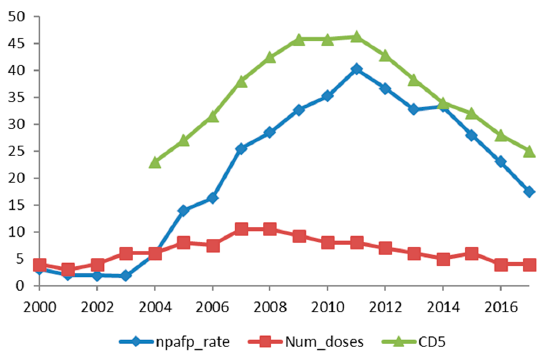
Figure 1. Non-polio AFP over the years in the state of UP alongside the 5-year cumulative doses of OPV. npafp_rate: Non-polio acute flaccid paralysis rate; Num_doses: Number of pulse polio rounds; CD5: Cumulative doses in the past 5 years.